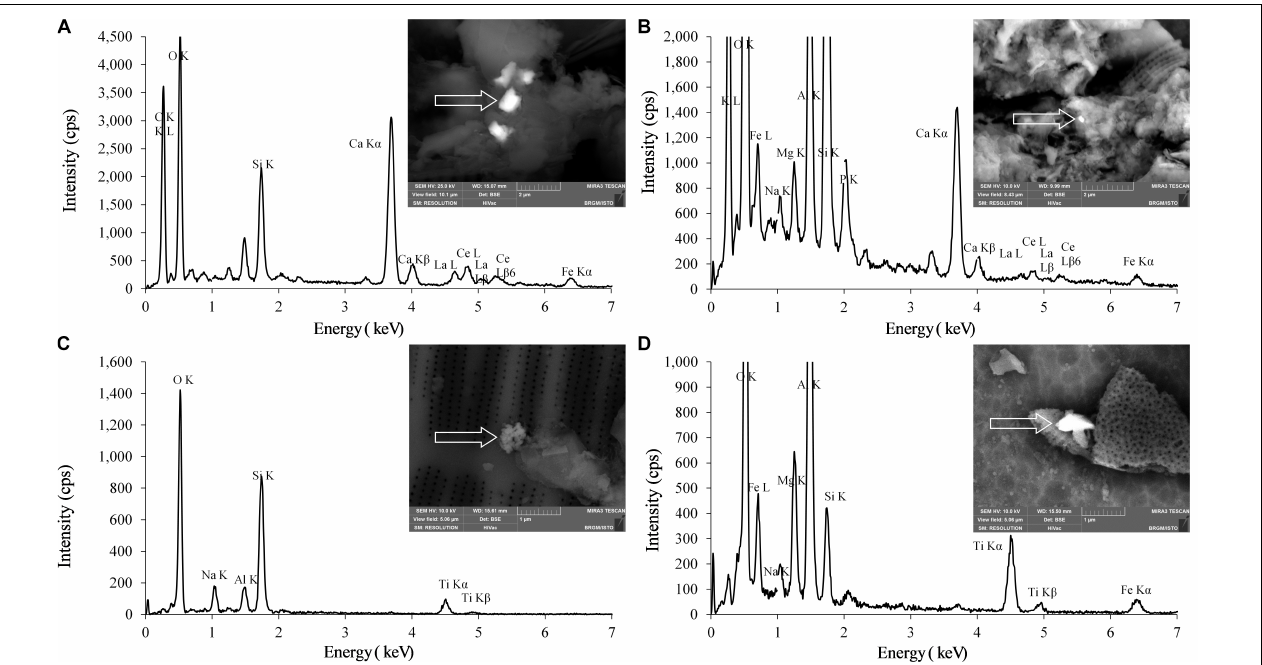
FIGURE 7 | FEG-SEM pictures of particles containing Ce and Ti and the associated EDS spectra on different sampling sites (A) LS6, (B) LS7, (C) LS2, and (D)